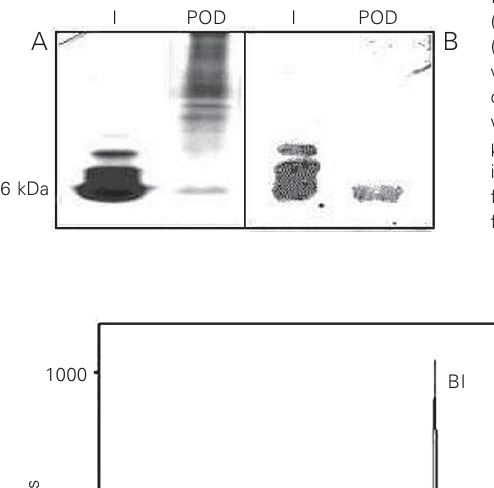
Figure 1. SDS-PAGE and West- ern blot of proteins extracted from 10 days after pollination (DAP) pods (empty) of cowpea ( Vigna unguiculata ). SDS-PAGE was done under nonreducing conditions. A , Protein staining with Coomassie brilliant blue (50 µl). B , Western blot. I, bovine insulin; POD, proteins isolated from empty pods of 10 DAP